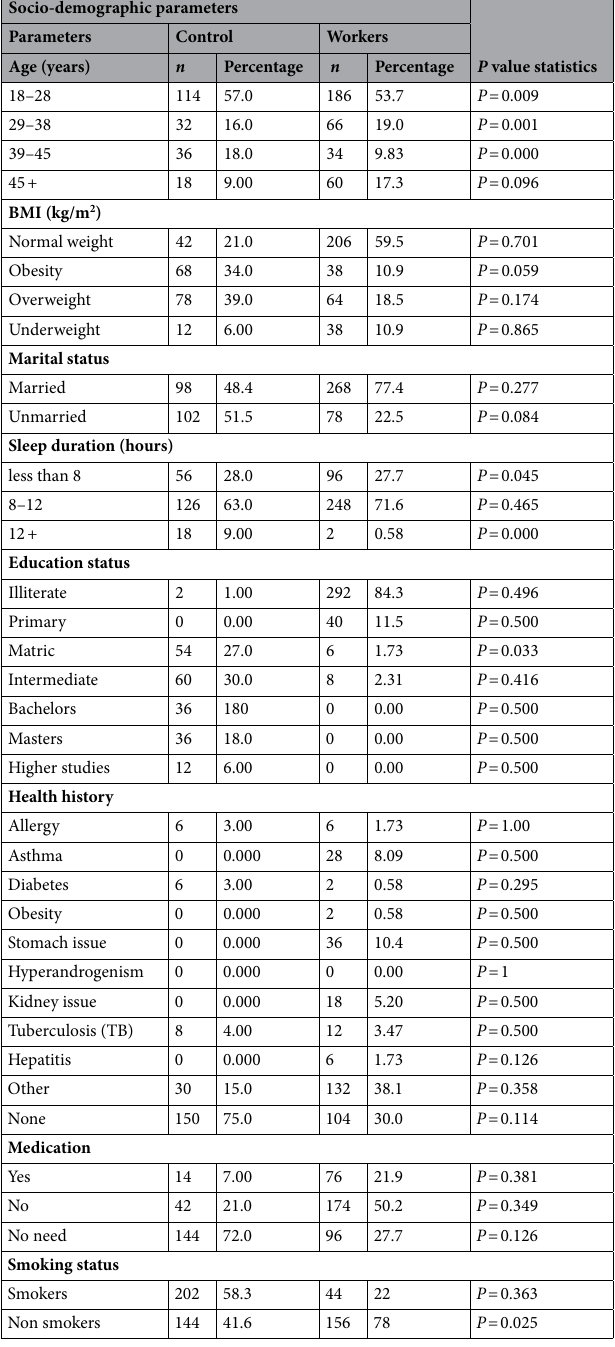
Table 1. Sociodemographic characteristics of surveyed brick kiln male workers from Rawalpindi,